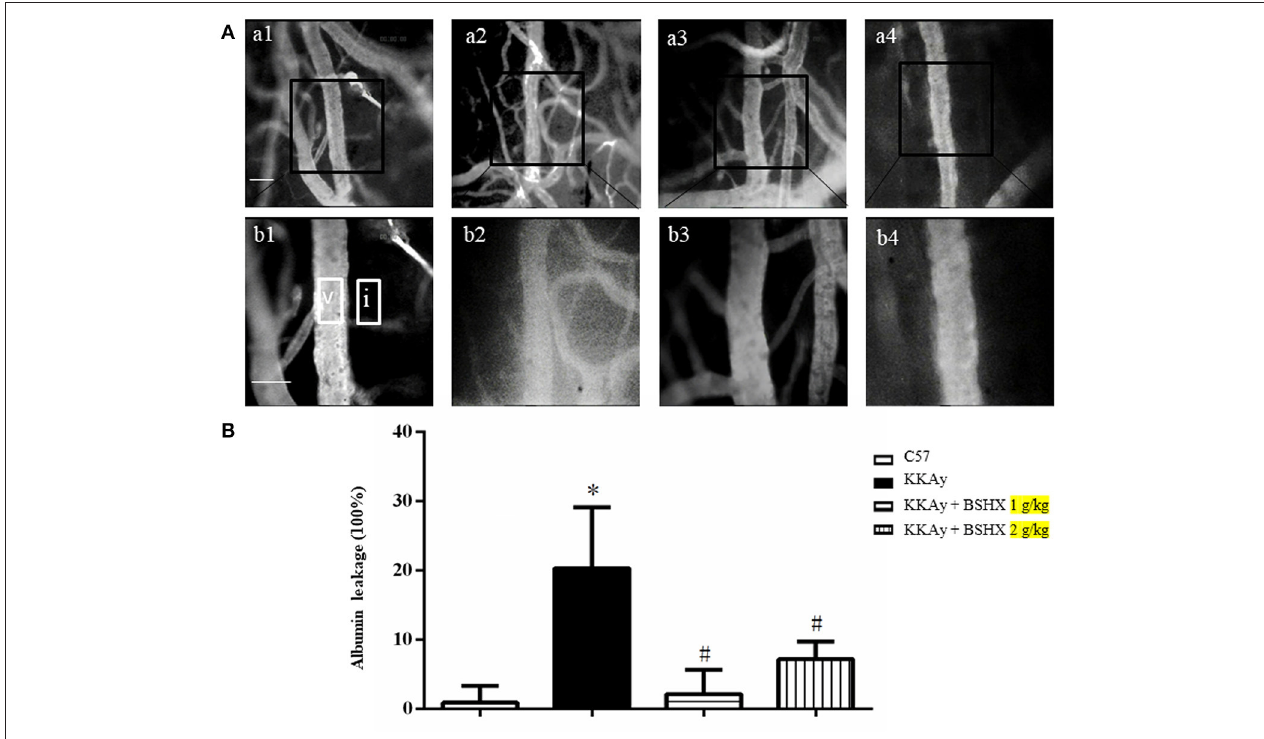
FIGURE 4 | The effect of BSHX on albumin leakage from cerebral venules. (A) Representative images of albumin leakage from venules in all groups. Rectangles represent the areas for determination of fluorescence. V: cerebral venule. I: Interstitial tissue. a1: C57 group; a2: KKAy group; a3: KKAy + BSHX 1 g/kg group; a4: KKAy + BSHX 2 g/kg. High magnifications of a1–a4 are shown below as b1–b4, respectively. Bar = 50 µ m. (B) Statistic analysis of albumin leakage. Data were expressed as mean ± SD ( n = 6). * p < 0.05 vs. C57 group, # p < 0.05 vs. KKAy group.